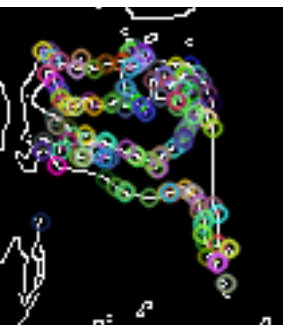
Figure 5. BRISK keypoints on hand edges.